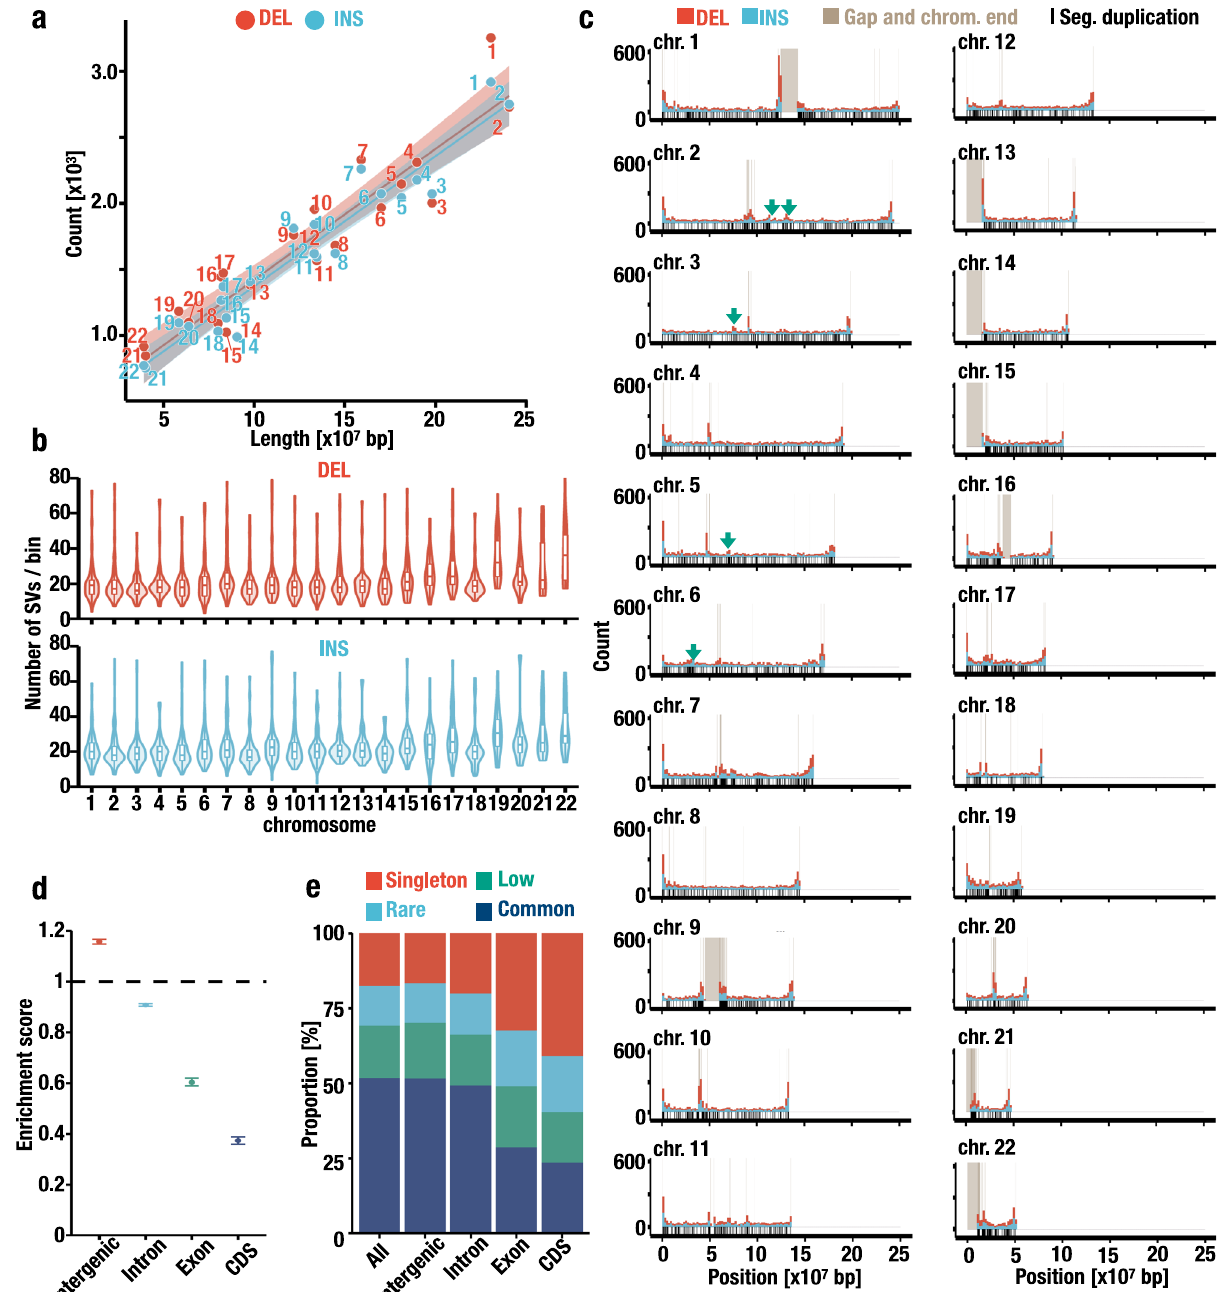
Fig. 5 Distribution of SVs at the chromosome scale. a Correlation between the chromosome length and the number of DELs (red) and INSs (blue). The lengths of the N-gaps are excluded from the chromosome length. Regression lines, 95% con fi dence intervals, and chromosome names are also shown. b Number of SVs per 2-Mb bin per chromosome. Each boxplot has a box that represents the interquartile range (IQR) and whiskers that extend 1.5 × IQR from the box edges. The median is shown in a horizontal line in the box. c Distribution of SVs at the chromosome scale. The numbers of DELs and INSs per 2-Mb bin are shown in red and blue, respectively. Positions of gaps and chromosome ends in GRCh38 are highlighted in brown. Green arrows indicate SV peaks that are more than 5 Mb away from the gaps. The positions of segmental duplications are shown in black rugs under the histogram. d Overlap between SV positions and genomic features. Expected frequencies of SVs that overlapped with each genomic feature (intergenic, intron, exon, and coding sequence [CDS]) were set to 1, and the observed frequencies are shown. The error bars represent the minimum and maximum values of the enrichment score. n = 1000. e Enrichment of rare SVs in functional genomic features. The proportions of singleton, low, rare, and common SVs that overlapped with genomic features are shown in red, green, blue, and navy, high-throughput long-read sequencing at the population scale. We also validated the reliability of the SV panel utilizing trio samples recruited in the TMM biobank to validate the panel by means of allele-frequency panel focusing on SVs. To pursue long-read Mendelian inheritance error pro fi ling. sequencing analyses at a population scale, it seems to be desirable